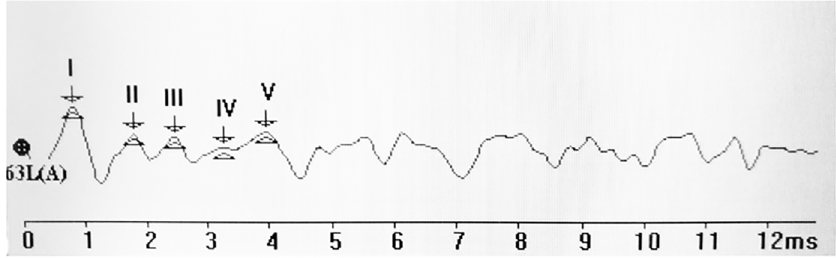
Fig 1. ABR waves for determination of hearing thresholds in mice. The ABR thresholdswere determined by the presenceof well-definedABR waves (I-V).